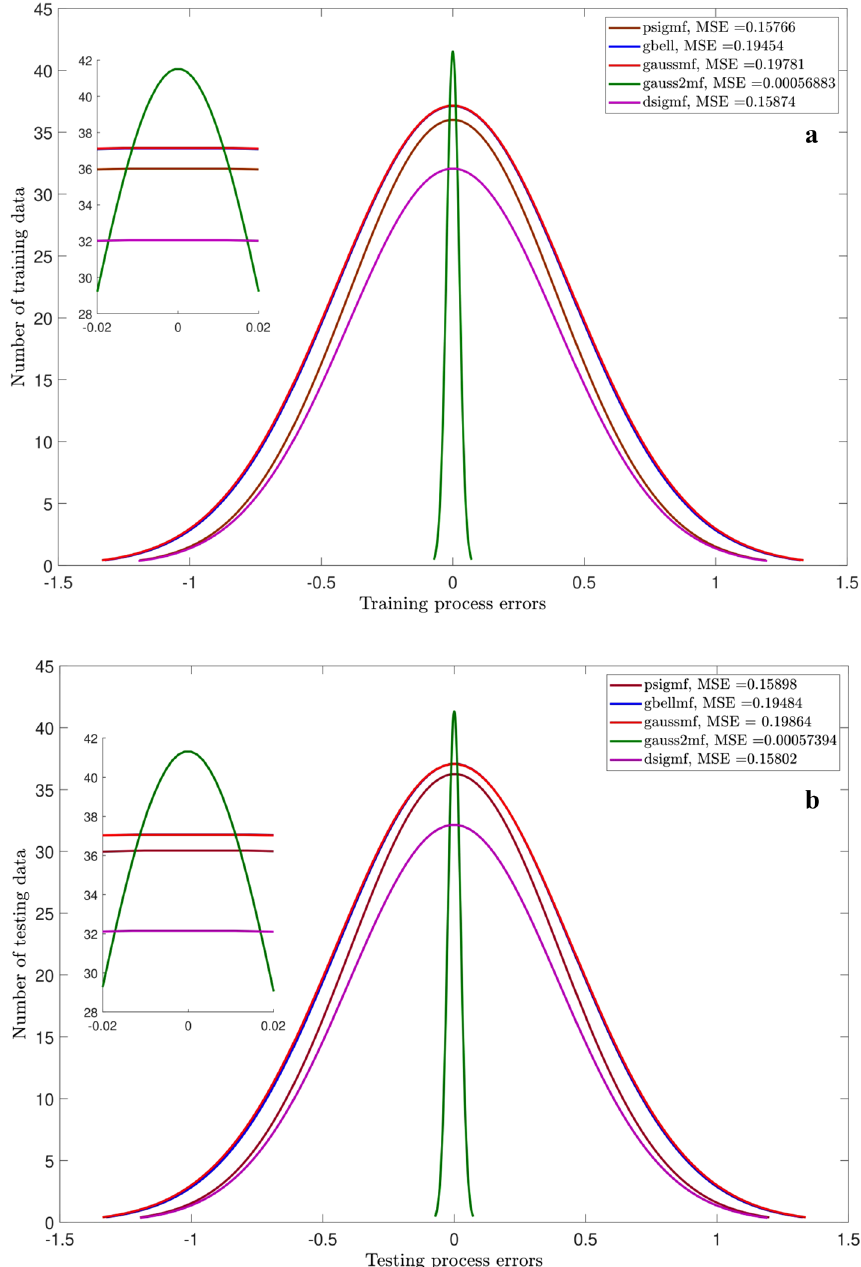
Figure 6. ( a ) Errors of training for different type of membership function when number of inputs is five. ( b ) Errors of testing for different type of membership function when number of inputs is